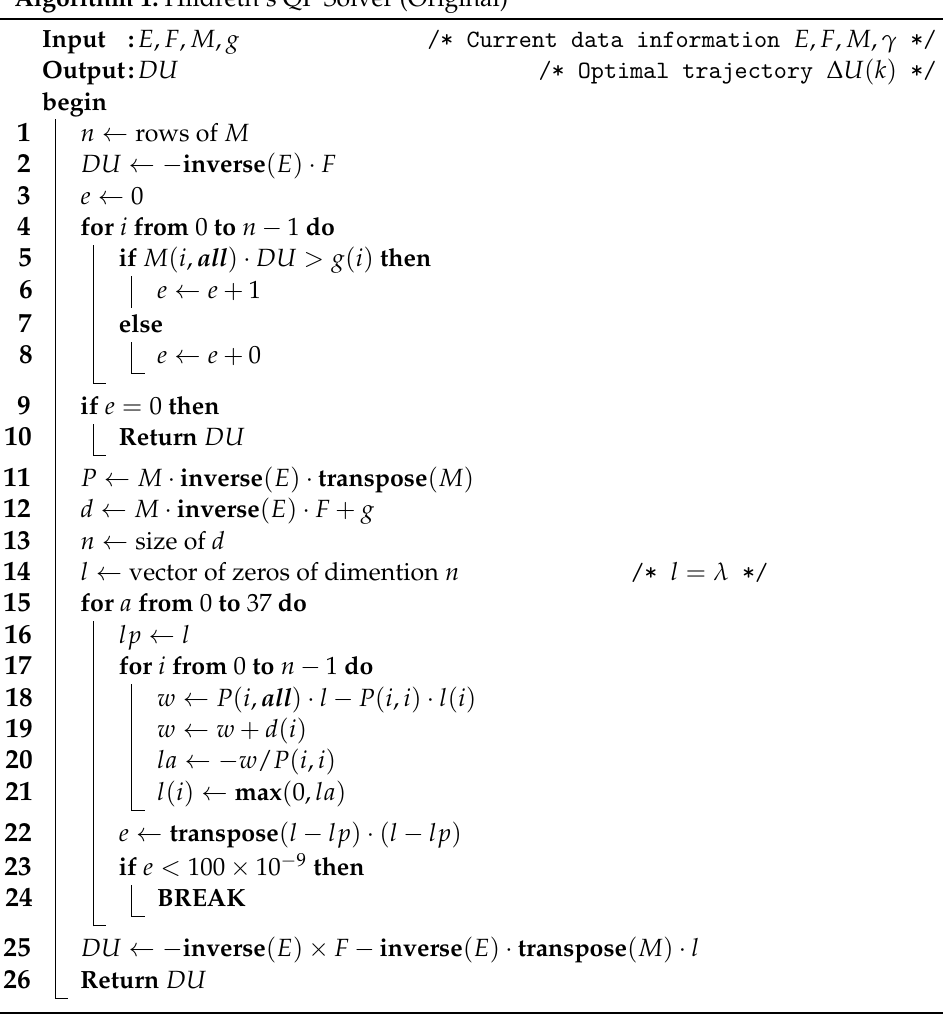
Algorithm 1: Hildreth’s QP Solver